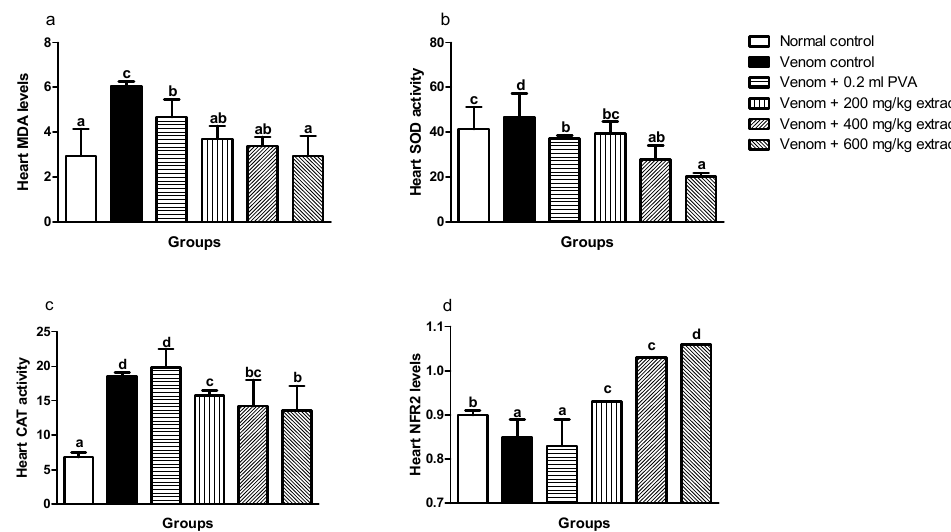
Figure 3. Effects of M. oleifera extract on MDA ( a ), SOD ( b ), and CAT ( c ) activities, and Nrf2 levels ( d ) in the heart of rats challenged with E. ocellatus venom. Data are expressed as mean ± SD ( n = 3). Bars with different letters are statistically distinct ( p < 0.05). PVA: polyvalent antivenom; CAT: catalase; SOD: superoxide dismutase; MDA: malondialdehyde; NRF2: nuclear factor erythroid 2–related factor 2.